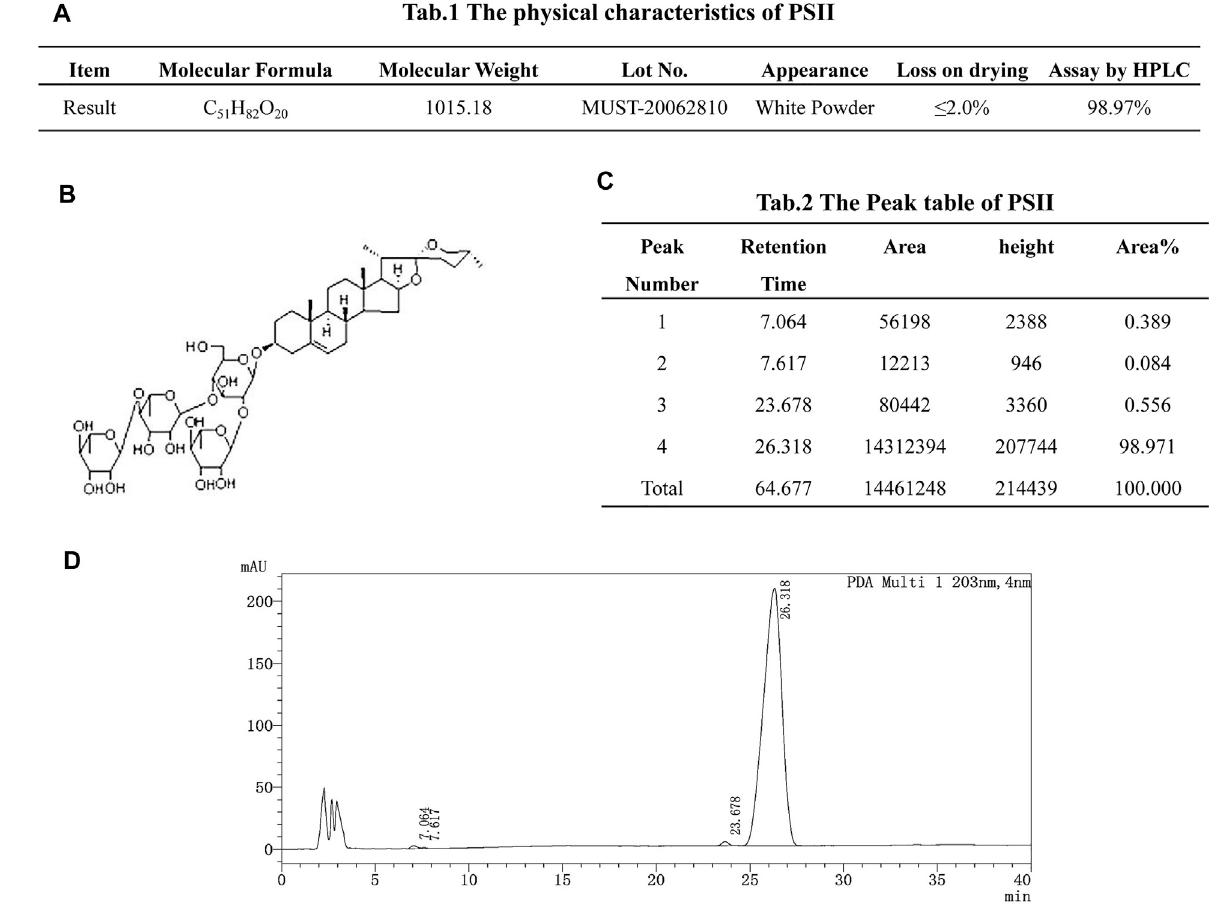
FIGURE 1 | Drug instruction. (A) The physical characteristics of PSII. (B) Structural formula of PSII. (C) The peak table of PSII. (D) The peak fi gure of PSII. Eluant: acetonitrile:water (cid:2) 50/50, 50 min. Flow velocity: 1.0 ml/min. Chromatographic column: MinXi Teeh CG-C18 5mic 250 × 4.6 mm. Column temperature: 40 ° C. The sample solvent: methyl